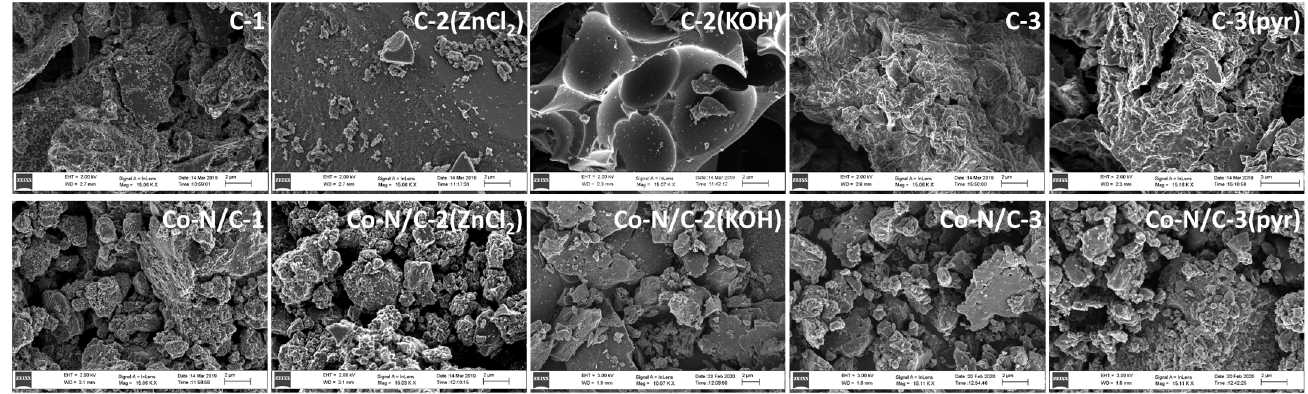
Figure 2. Surface images measured using HR-SEM for various samples (noted in Figure). Table 1. Elemental composition (wt%) of studied materials measured by